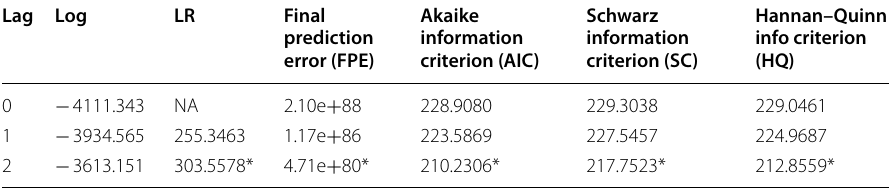
Schwarz information criterion (SC)